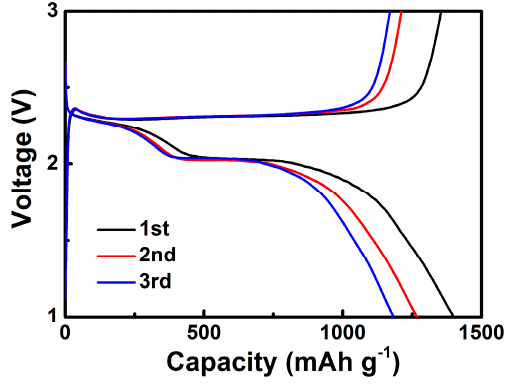
Figure 8. Charge and discharge curves of the S/GO composite electrode.